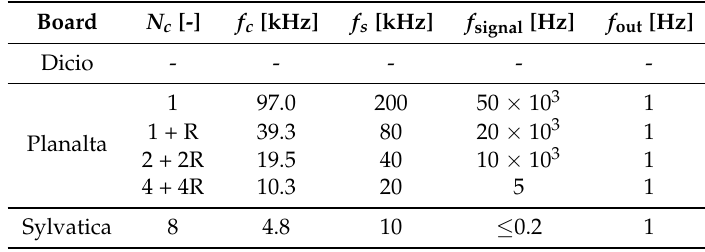
Table 1. Overview of the different sampling and signal frequencies employed in the sensor boards Planalta and Sylvatica. N c is the maximum number of active channels, where “R” denotes that the output of the signal driver is also sampled (top analogue-to-digital converters (ADC) block in Figure 2). f c is the analogue cut-off frequency of the anti-aliasing low-pass filter in front of the ADC. f s is the sampling frequency of a specific ADC channel. The frequency depends upon the number of active channels. f signal is the (modulated) signal frequency. The filter cascade reduces the input signal to a 1 kHz signal, as indicated by f out